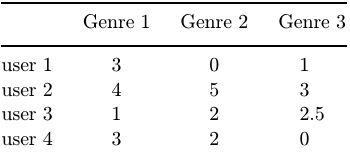
Table 5. Example of genre ratings.